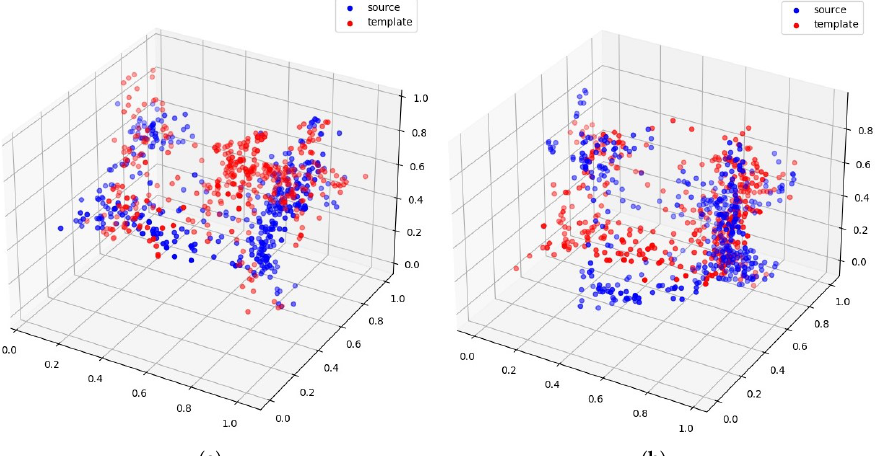
Figure 3. ( a ) Template 2; ( b ) Template